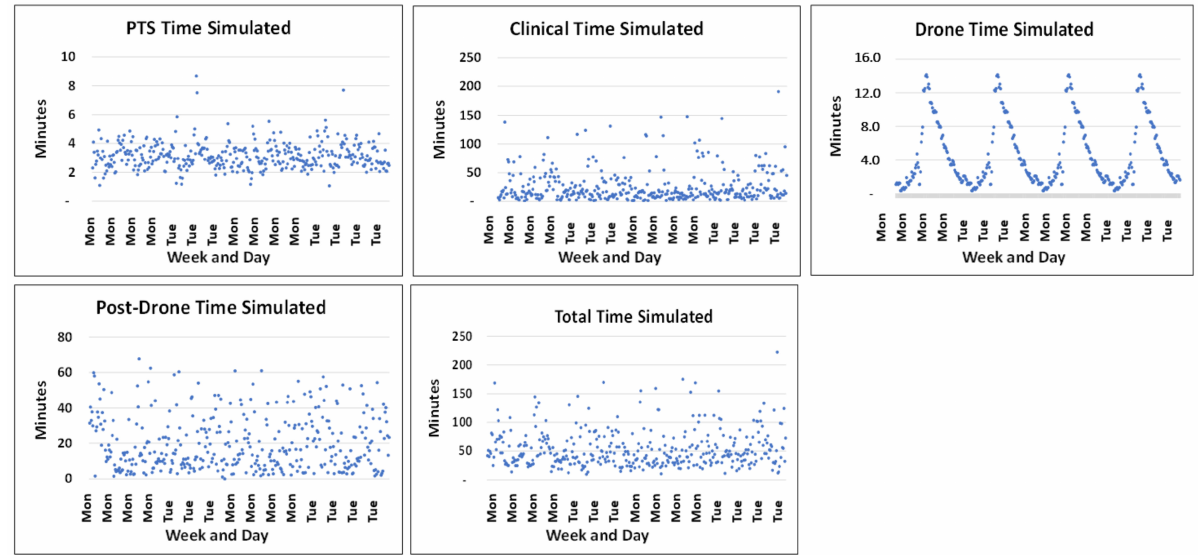
Figure 12. Individual times of PTS transport, clinical time, drone time, post-drone time and total time (sum of all) during